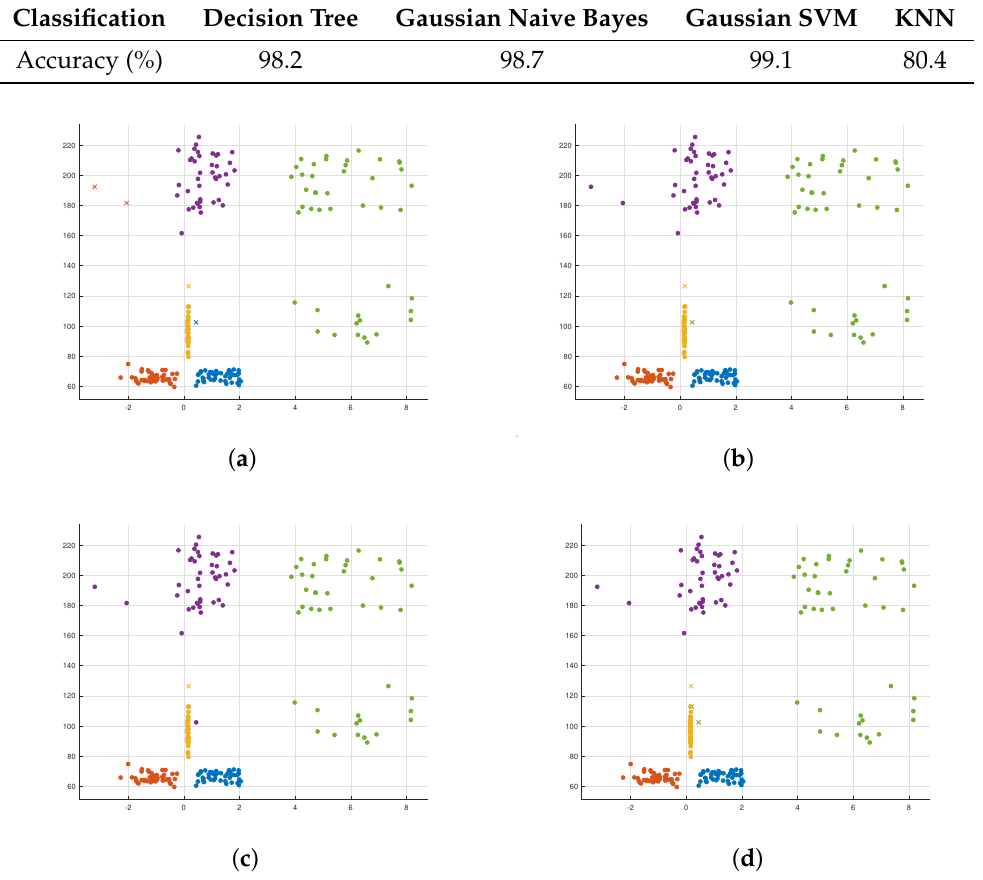
Table 2. Classification Comparison in Decision Tree, Gaussian Bayes, Gaussian SVM and KNN.